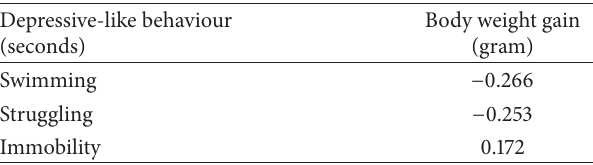
Table 2: Correlation between the body weight gain and depressive- like